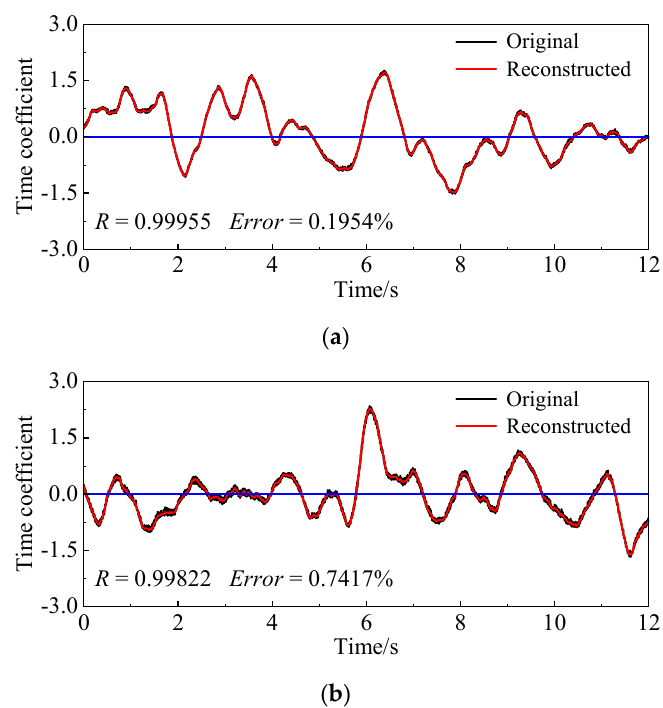
Figure 13. Contrast of reconstructed signal and original signal: ( a ) None; ( b ) Control. Table 2 sums up the number of modes in which the reconstructed time coefficient is zero for different TKE levels. In the same case, the number of corresponding modes of the forced state exceeds that of the unperturbed flow, and the reconstructed signal of the latter does not appear to be zero until the energy ratio reaches 90%. The explanation for this phenomenon is that the periodic perturbation injected into the flow field causes the energy to be redistributed, and the low-frequency components in each order mode transition to the high-frequency components.